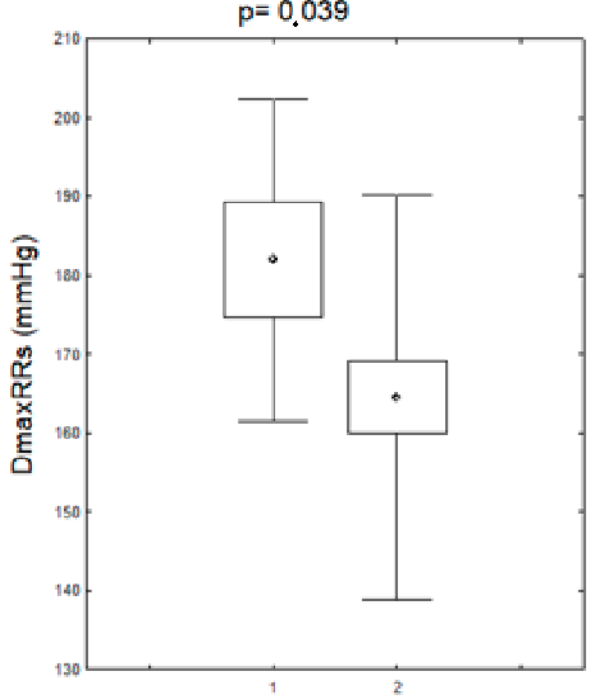
Figure 3. Maximum systolic blood pressure values during the day in patients (pre- and postmenopausal) with arterial hypertension with the changes in the HV1 regions. DDmaxRRs-daily maximum systolic blood pressure, HV1+,-positive for HV1 changes, HV1 − ,-negative for HV1 changes. 3.7. Nucleotide Sequence Changes in HV2 and RR Monitoring Modifications in the nucleotide sequence in the HV2 mtDNA region were accompa- nied by slightly higher mean values of the maximum systolic RR both during the day and night, as well as significantly higher heart rate/min during the day. The comparison of RR monitoring parameters in the subjects (pre- and postmenopausal) in the group with changes in the nucleotide sequence in the HV2 hypervariable region to the group without changes is presented in Figure 4.